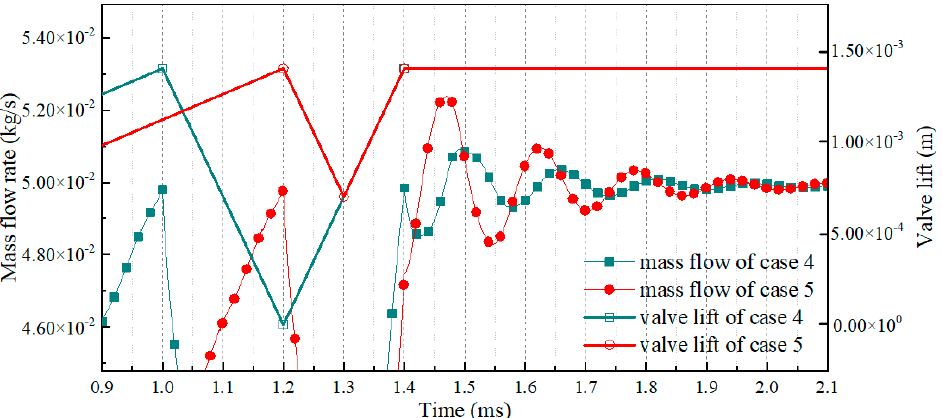
Figure 10. Valve lift vibrations and mass flow rates of case 4 and case 5 (they had the same valve vibration speed).